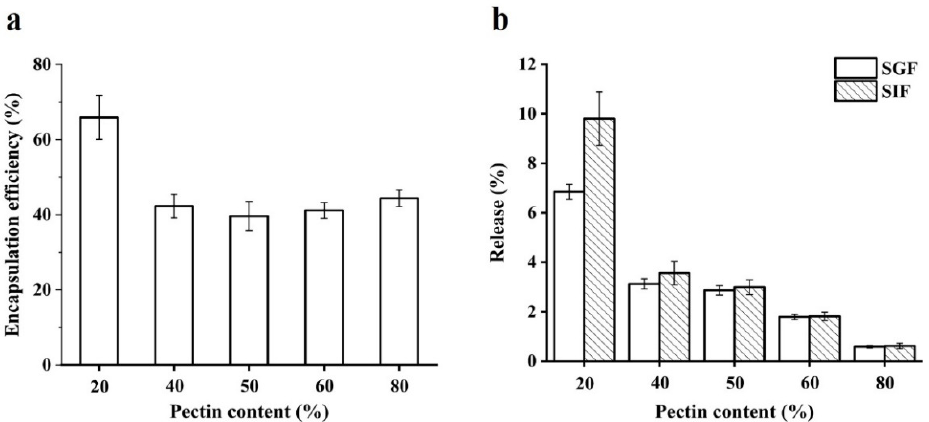
Figure 6. Encapsulation efficiency of quercetin from beads with different content of pectin ( a ); the release amount of quercetin from beads with different content of pectin in simulated gastrointestinal fluids ( b ). SGF and SIF represent simulated gastric fluid and simulated intestinal fluid, respectively.